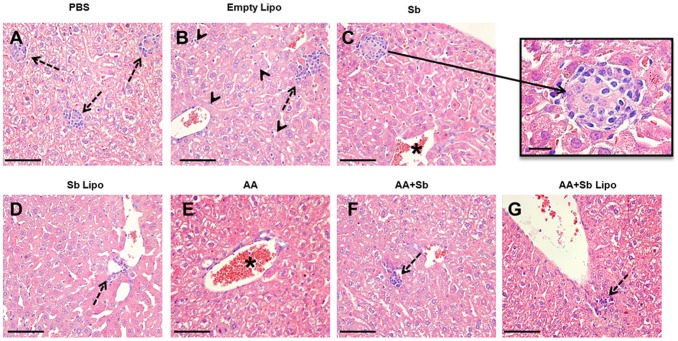
Histopathological analyses of the liver from L. infantum infected mice submitted to different treatment regimens.(A) Phosphate-buffered saline (PBS). (B) Empty liposomes (Empty Lipo). (C) Trivalent antimony (Sb). (D) Antimony entrapped liposomes (Sb Lipo). (E) Ascorbic acid (AA). (F) Ascorbic acid in association with antimony (AA+Sb). (G) Ascorbic acid in association with antimony entrapped liposomes (AA+Sb Lipo). Bar  = 50 µm. Insert  = 25 µm, representing an immature granuloma. Dashed arrow  =  Inflammatory cell foci. Arrowhead  =  Kupffer cells exhibiting hypertrophy. * Hyperemic vessels.